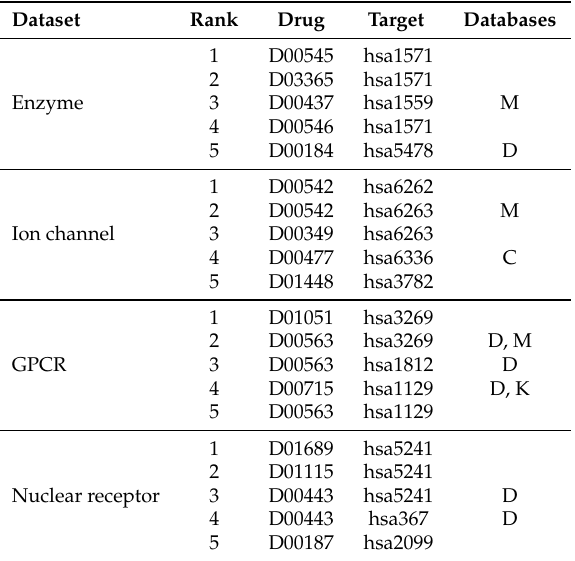
Table 5. Top five new DTIs predicted by DAWN on four data